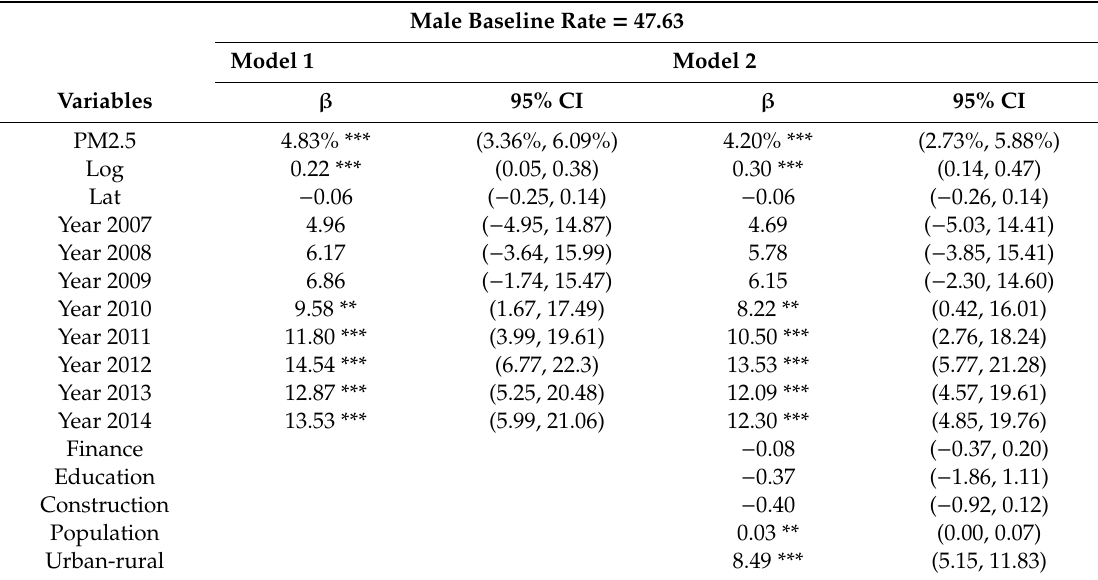
Table 2. Association between concurrent PM2.5 and the incidence rate of lung cancer for males. Male Baseline Rate = 47.63